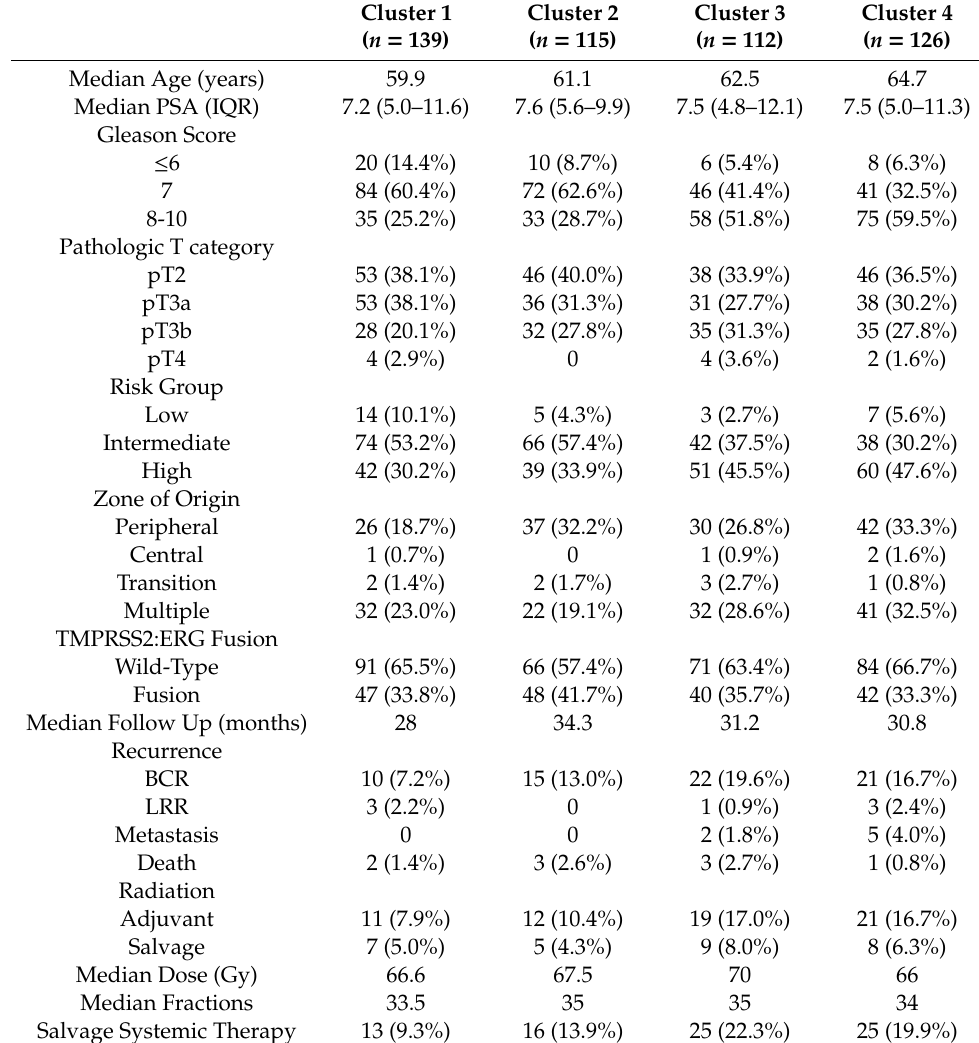
Table 1. Demographic and treatment data for all patients in the TCGA PRAD cohort, divided by